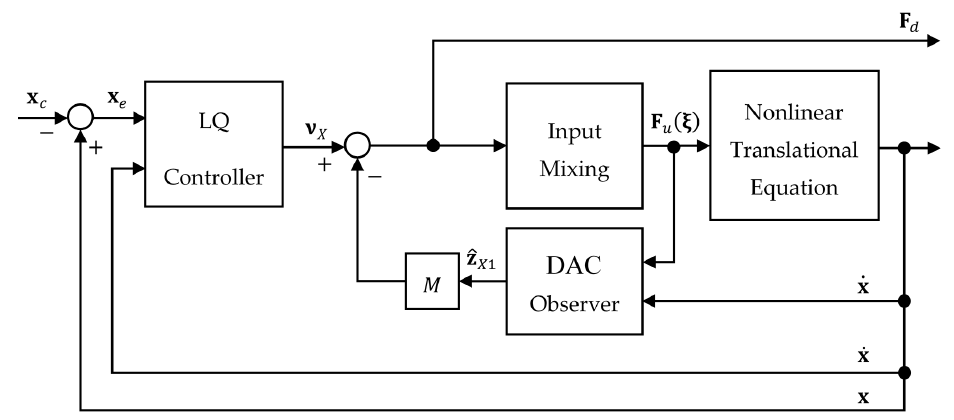
Figure 5. Block diagram of proposed translational control system.